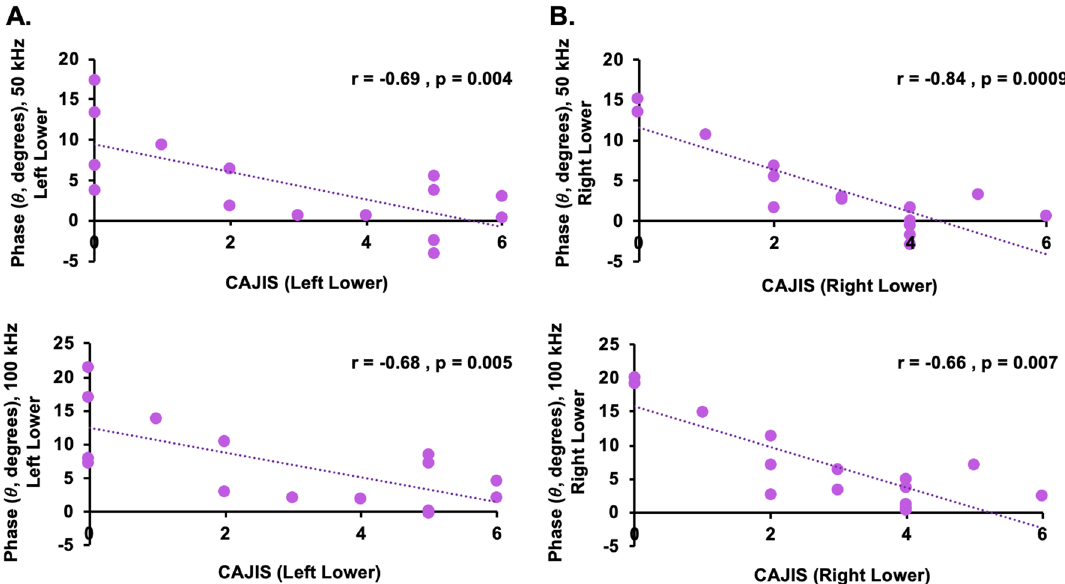
Figure 5. Association between regional CAJIS scores and θ . At both 50 and 100 kHz, robust negative correlations between CAJIS scores and θ in the left lower ( A ) and right lower ( B ) regions were observed. Such localized associations further support the ability of EIM to detect both regional and whole-body changes in muscle tissue integrity in FOP patients. Parameter Body part FOP (N = 15) Healthy controls (N = 13) Whole body r = 0.64, p =